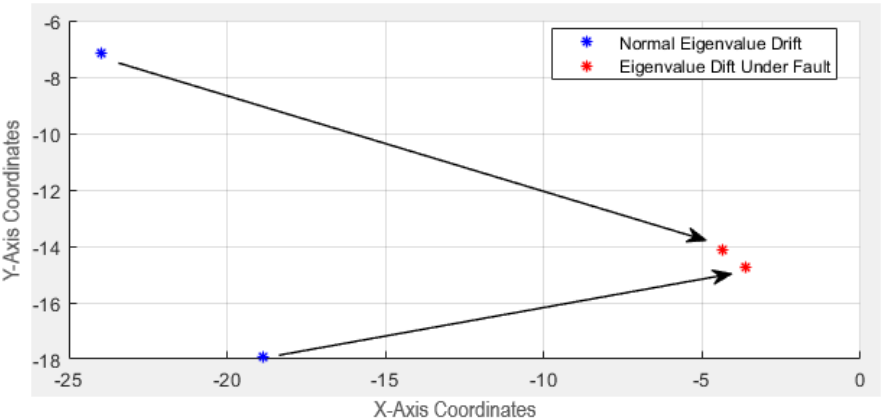
Figure 10. Eigenvalue drift during a fault with a resistance of 100 Ω .